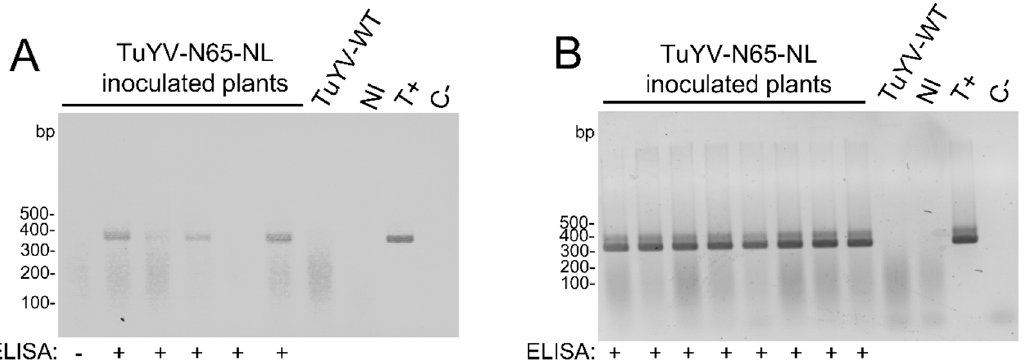
Figure 5. Analysis of viral progeny by reverse transcription ‐ polymerase chain reaction (RT ‐ PCR) in non ‐ inoculated leaves of Nicotiana benthamiana 35S:C66 ‐ NL line 1 ( A ) and line 3 ( B ) agro ‐ inoculated with TuYV ‐ N65 ‐ NL. Total RNA was isolated two weeks post ‐ inoculation from plants positive (+) or negative ( − ) in ELISA. For PCR, primers binding to the beginning of the NanoLuc sequence and to the 3 ′ UTR of the TuYV genome and amplifying a 337 bp fragment were used. TuYV ‐ WT, plants inoculated with wild type TuYV; NI, non ‐ inoculated plants; T+, positive plasmid control (pTuYV ‐ N65 ‐ NL); C − , non ‐ template control; bp, base pairs.